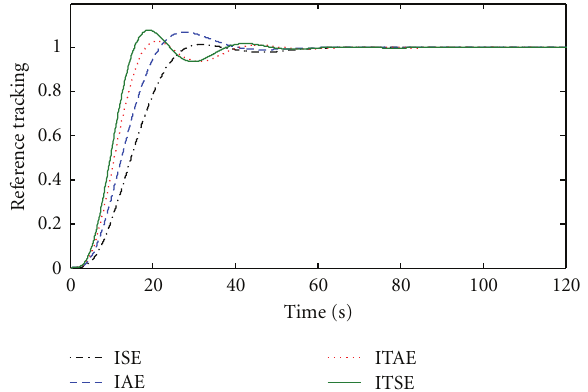
Figure 15: Servo response for Example 3 with BFO-based I-PD controller.